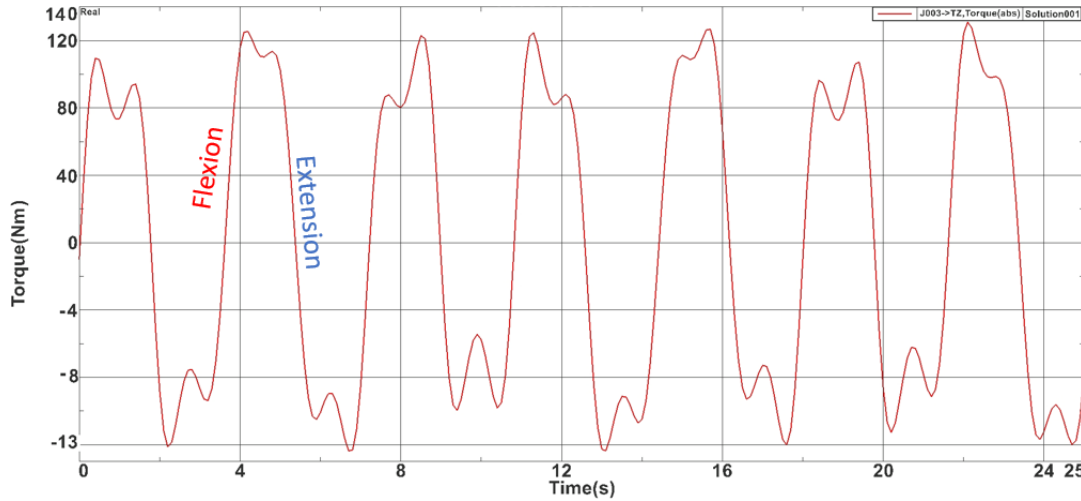
Figure 5. Torques recorded during the flexion-extension module simulation.